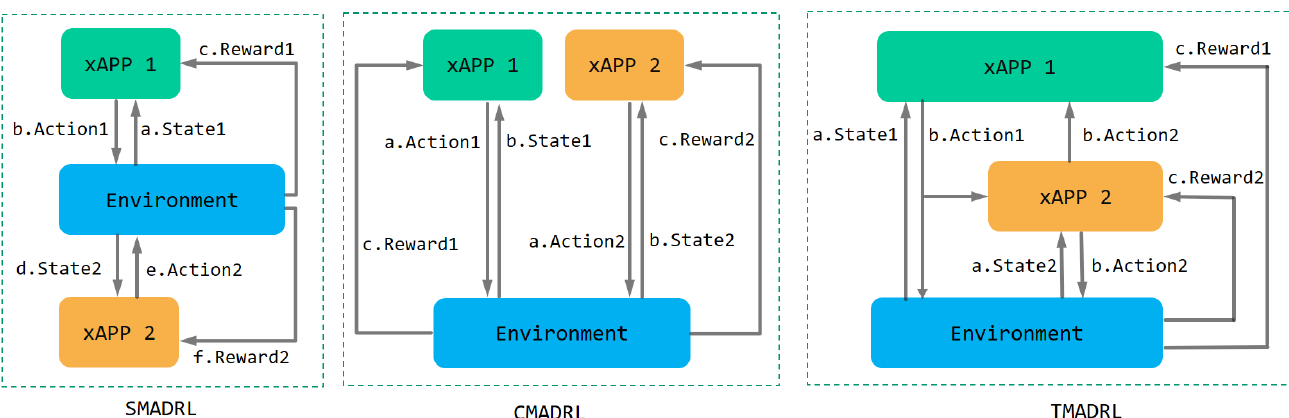
Figure 3. Sequential multi-agent deep reinforcement learning (SMADRL), Concurrent multi- agent deep reinforcement learning (CMADRL) and Team multi-agent deep reinforcement learning (TMADRL)